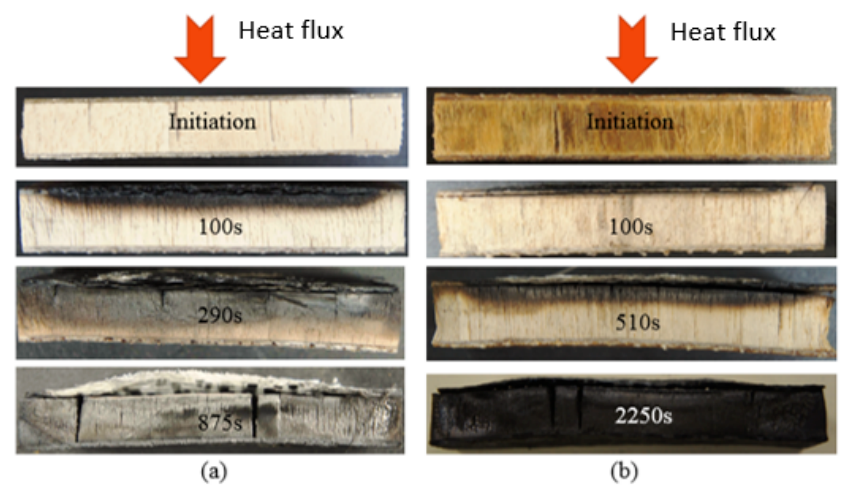
Figure 6. Cross-sectional view of the during fire exposure of the dry specimens ( a ) and the moisture saturation specimens ( b ).